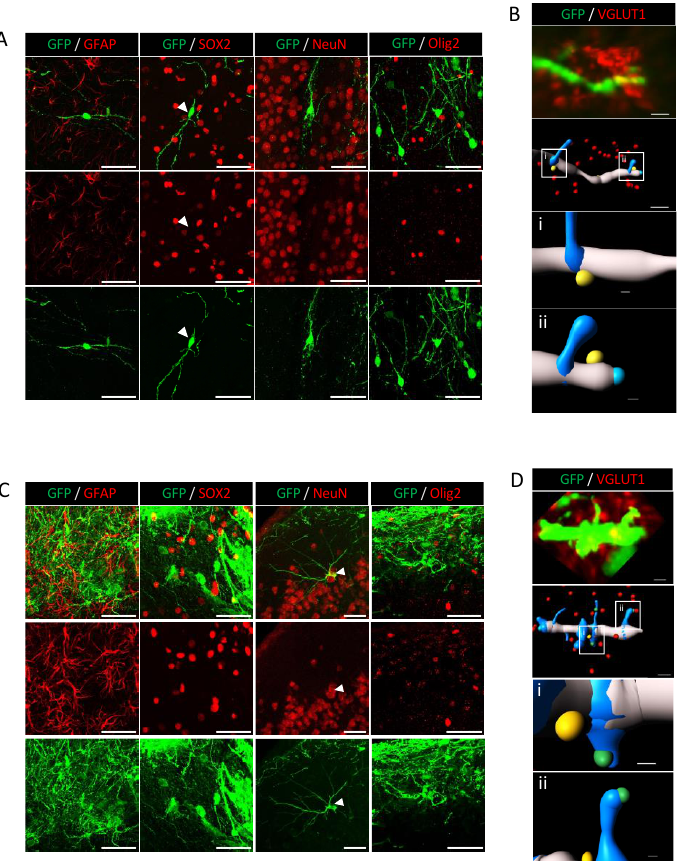
Figure 5. NPCs differentiate into glutamatergic neurons at 3 MPT. Immunofluorescence staining of NPC-derived neurons by GFAP, SOX2, NeuN, and VGLUT1 at 3 MPT after LV ( A , B ) and PFC ( C , D ) transplantation. Left to right panels, no positive human cells were found for GFAP, Sox2, NeuN, and Olig2 (no double-labeled cells). ( B ). Punctiform labeling of dendritic segment was observed for VGLUT1, clearly illustrated by a 3D zoomed-in image showing distinct VGLUT1 punctae represented in yellow (Bi, Bii). ( C ). Left to right panels, no positive human cells were found for GFAP, Sox2 and Olig2. Positive labeling for NeuN marker showing the nuclei of pyramidal neurons within the PFC (arrowhead). ( D ). Punctiform labeling of dendritic segment and associated spines was observed for VGLUT1, clearly illustrated by a 3D zoomed-in image showing distinct VGLUT1 punctae represented in yellow (dendrite) and green (spines) (Di, Dii). Scale bars = 50 µm (GFAP, SOX2, NeuN and Olig2 images), scale bars = 2 µm (reconstituted VGLUT1 images), and scale bars = 0.3 µm (zoomed images Bi, Bii, Di, Dii).